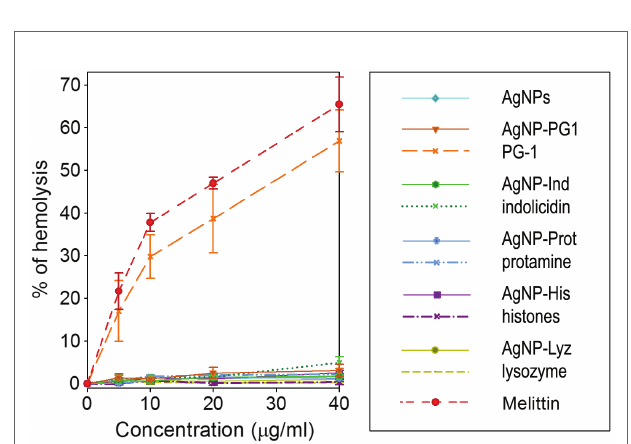
FIGURE 4 | Hemolytic activity of AgNP-AMP/AP conjugates. Hemolysis was compared to that caused by the corresponding antimicrobial peptides and proteins (AMPs and APs) and gelatin-only coated silver nanoparticles (AgNPs) alone. Results are shown as mean ± standard deviation and are calculated based on 3–4 independent experiments performed in triplicate. Well-known hemolytic peptide melittin (Sigma) from the honeybee venom is used as a reference hemolytic